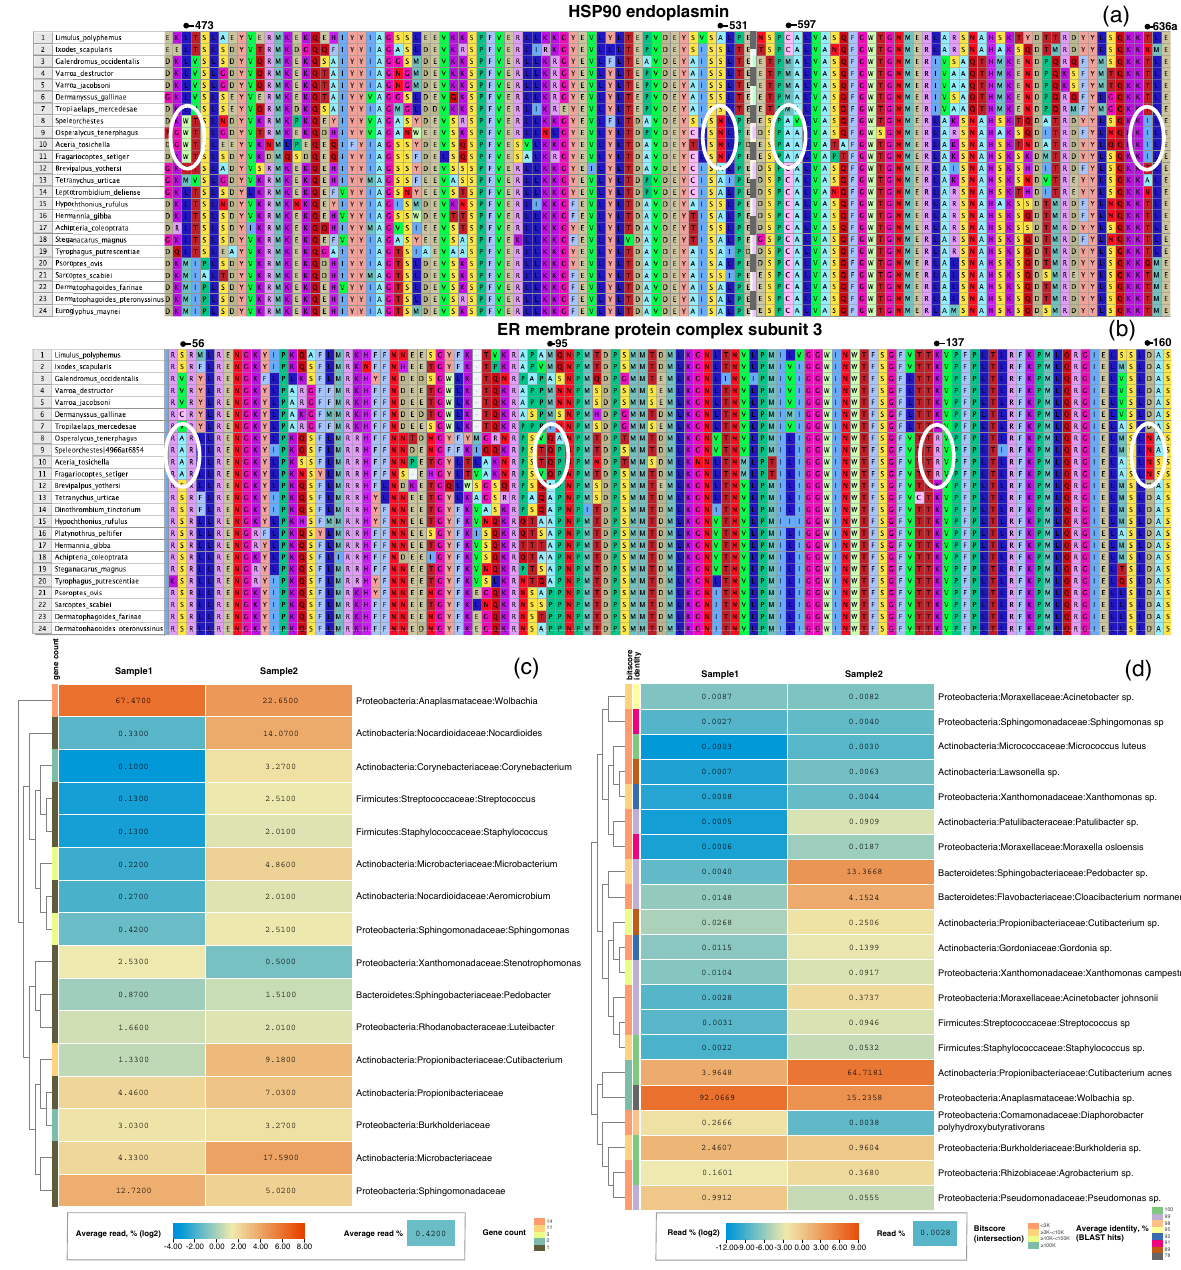
Figure 3. Select molecular autapomorphies for the Endeostigmata, including Eriophyoidea, in two proteins ( a , b ): HSP90 endoplasmin ( a ) and ER membrane protein complex subunit 3 ( b ); amino acid alignment coordinates are given for the Limulus polyphemus reference proteins (XP_013791125.1, XP_022251172.1). Bacterial OTUs shared between samples 1 and 2 as identified by mapping raw reads onto a set of 14 single-copy genes in singleM ( c ); for each OTU, a gene count returning matches in both samples is given. The heatmap gives read percentages in the intersection, while its colors are based on log 2 of these values. Normalization was done only for OTUs present in the intersection. Bacterial OTUs shared among samples 1 and 2 as identified via intersection of two assemblies ( d ); for each OTU, intersection bitscore, and average sequence identity (BLAST using GenBank nucleotide database) are given. The heatmap gives normalized read percentages, while its colors are based on log 2 of these values. Normalization was done only for OTUs present in the intersection. Only alignments having a bitscore ≥ 1500 are